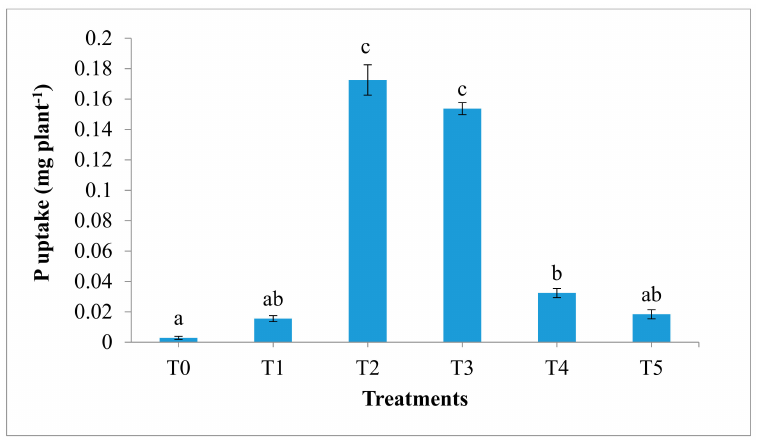
Figure 5. Effects of treatments on available P uptake at harvest (70 DAT). Mean values with different letter(s) indicate significant difference between treatments by Tukey’s test at p ≤ 0.05. Bars represent the mean values ± SE.